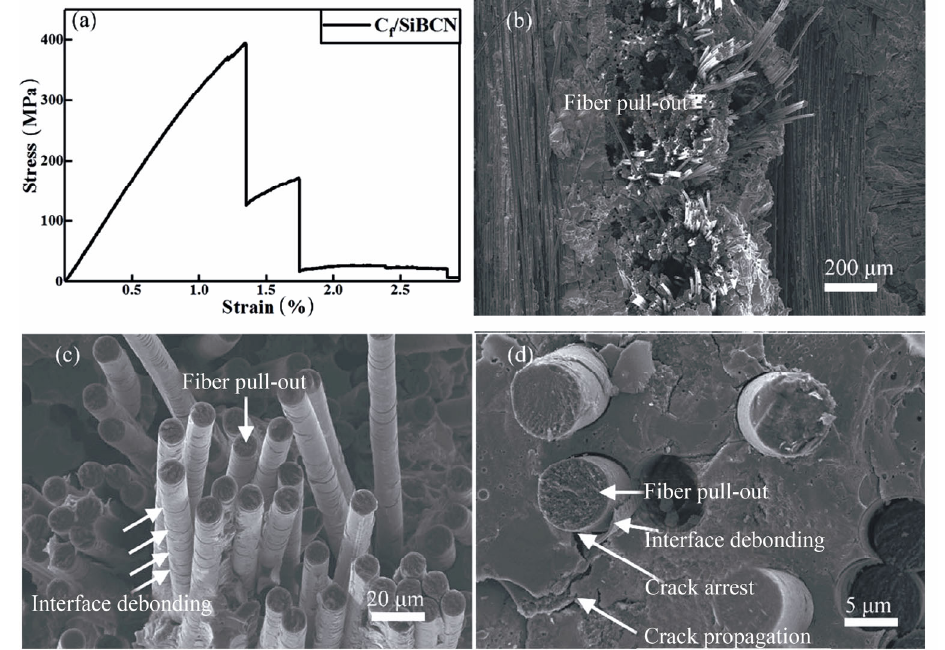
Fig. 9 (a) Typical bending stress vs. strain curve and (b)–(d) typical microstructure of fracture surfaces of the C f /SiBCN